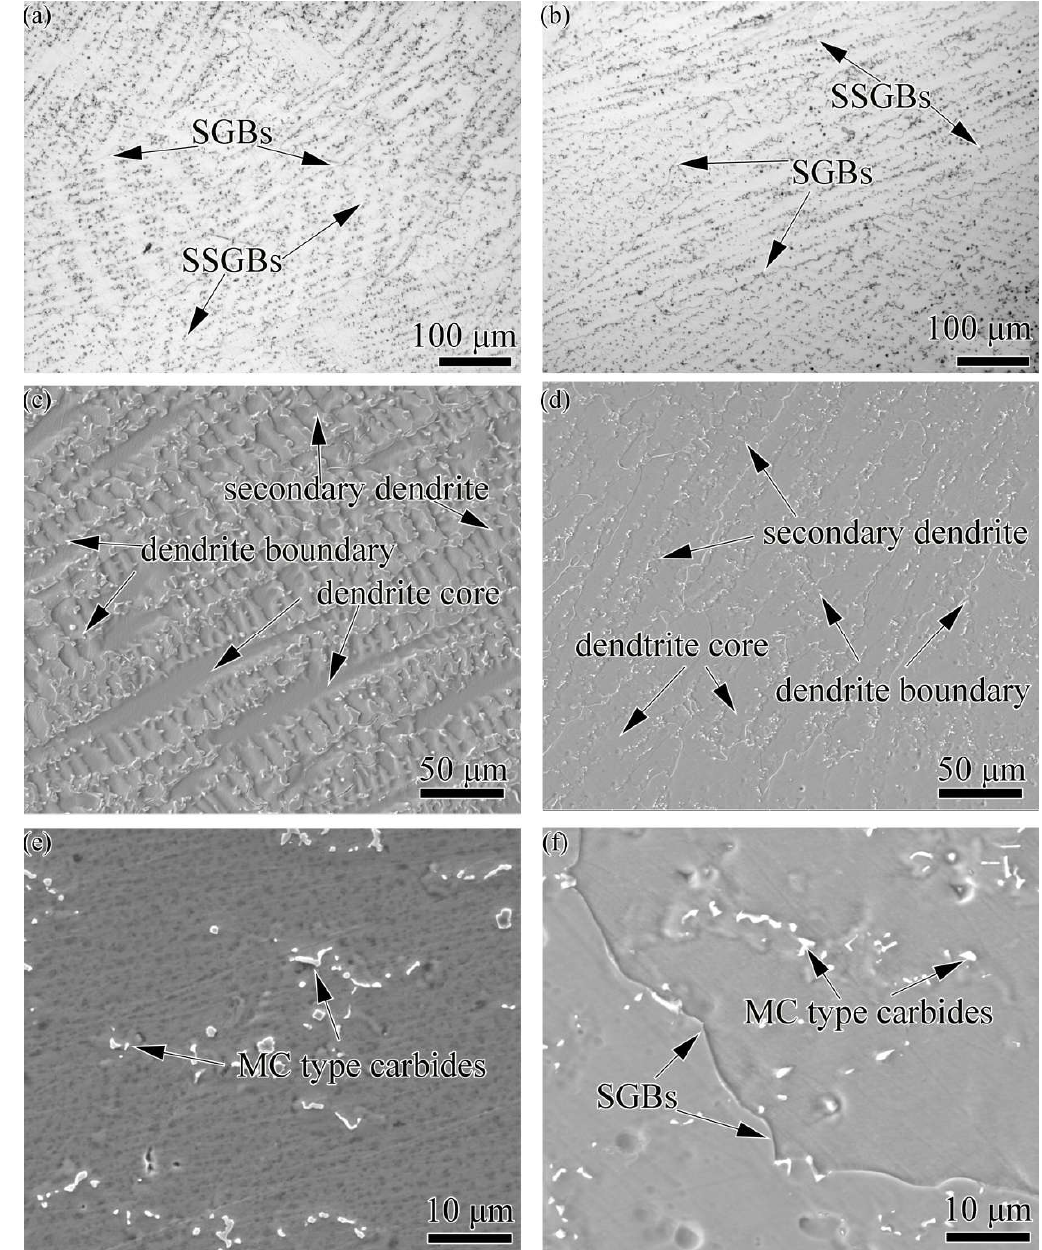
Figure 6. Microstructures of weld metal with Hastelloy X and K4750 filler material: ( a ) OM image of weld metal with Hastelloy X filler material; ( b ) OM image of weld metal with K4750 filler material; ( c ) SEM image of weld metal with Hastelloy X filler material; ( d ) SEM image of weld metal with K4750 filler material; ( e ) precipitates in Hastelloy X weld metal; and ( f ) precipitates in K4750 weld metal.